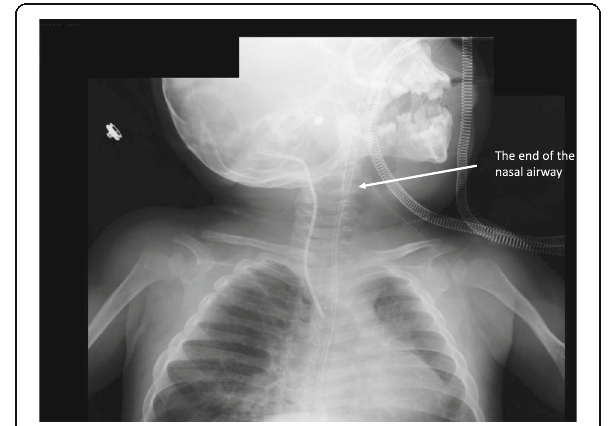
Fig. 1 A chest CT at healthy status. Several giant bullae in the bilateral lungs were observed